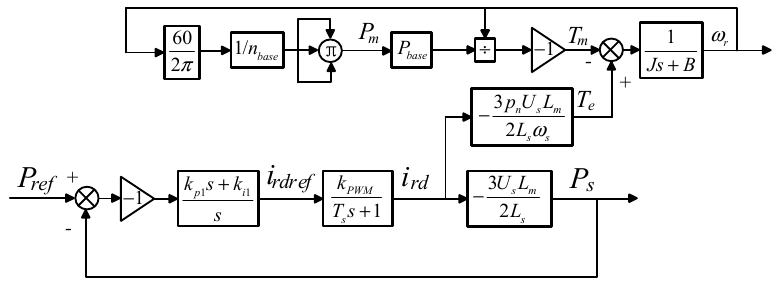
Figure 24. Control block diagram of stable operation stage under pump mode.